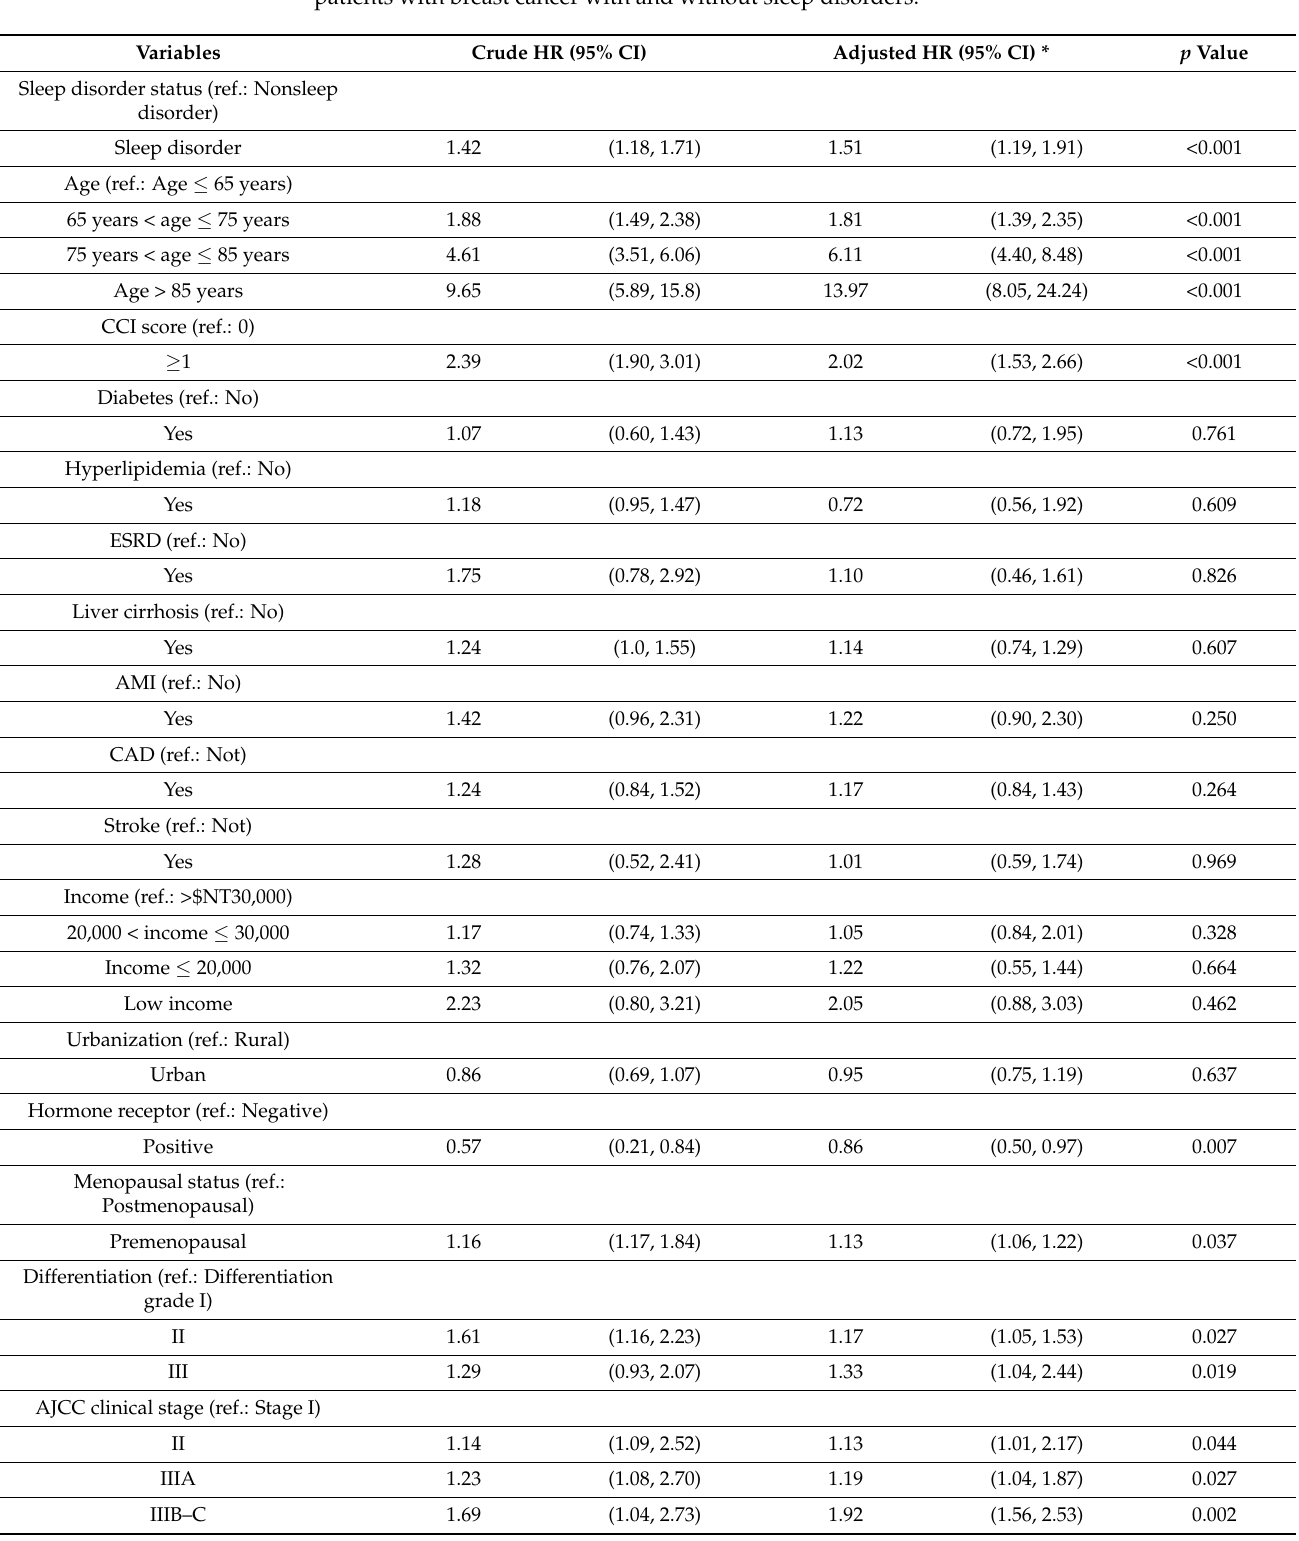
Table 2. Univariate and multivariate Cox proportional regression of all-cause mortality between patients with breast cancer with and without sleep